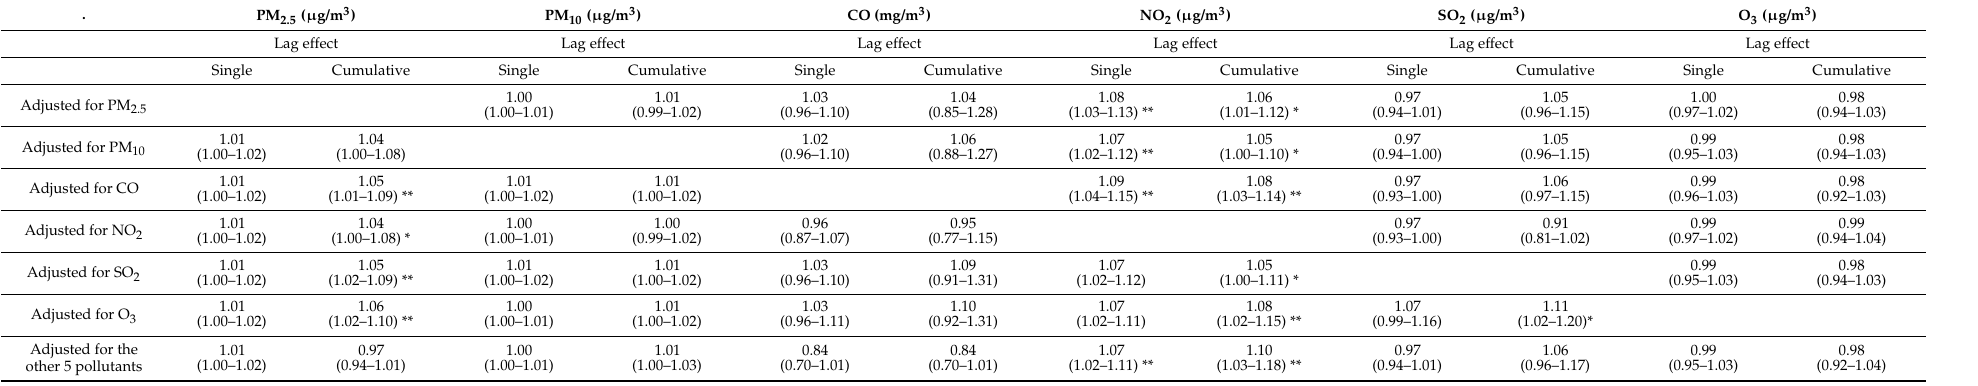
Table 3. Correlation of per 10 units increase in air pollutants and outpatients for DED: Multipollutant model.